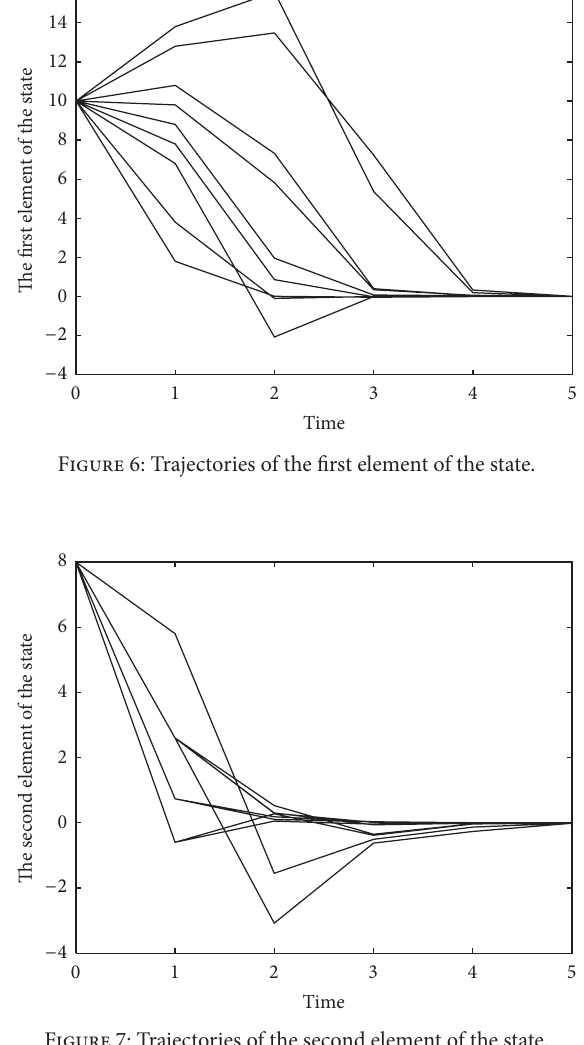
Figure 7: Trajectories of the second element of the